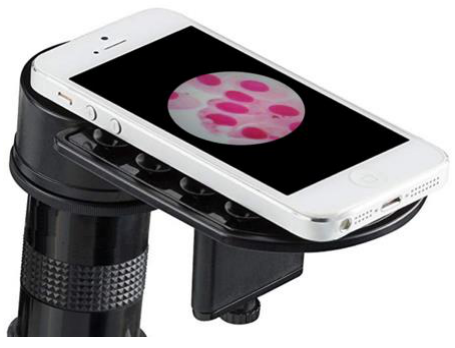
Figure 2. Image acquisition.